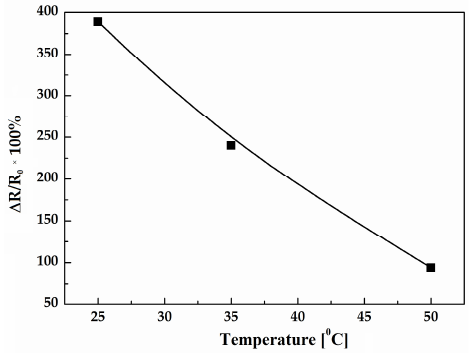
Figure 8. Temperature dependence of the sensitivity of f ‐ MWCNTs/Cu structure.